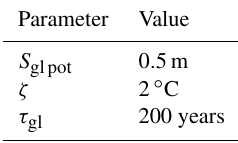
Table 5. Glacier model